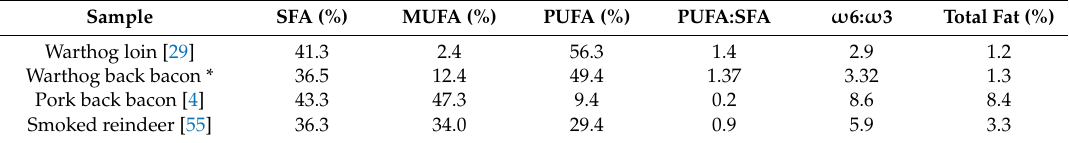
Table 8. The fatty acids composition (%) of warthog muscle, warthog back bacon other products. Sample SFA (%) MUFA (%) PUFA